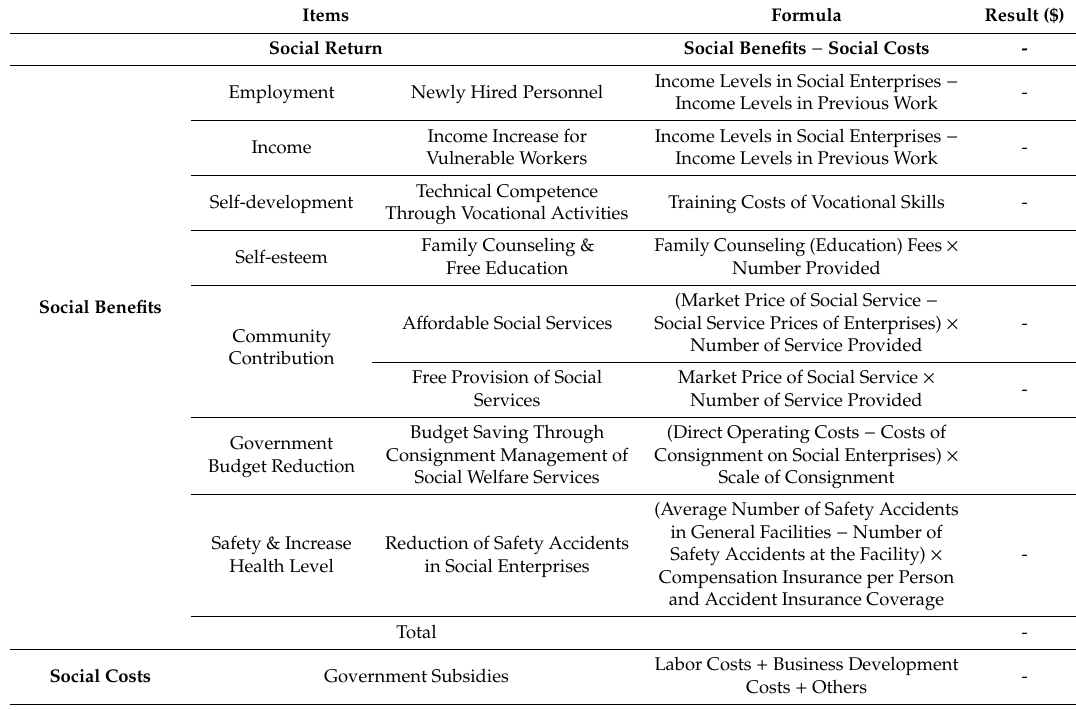
Table A1. Social Value Items.